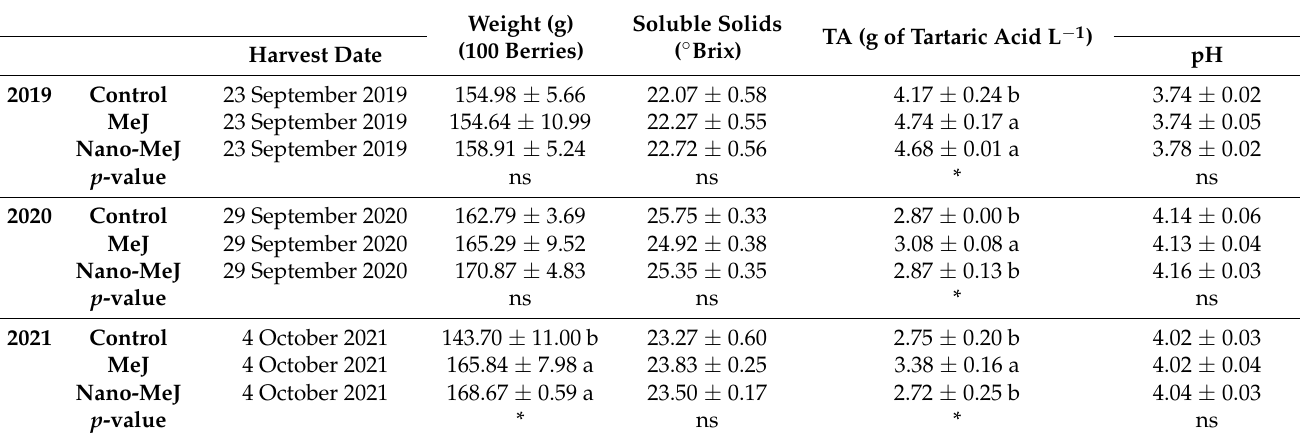
Table 1. Physicochemical characteristics of control and treated grapes (MeJ and nano-MeJ) and harvest date during three years.